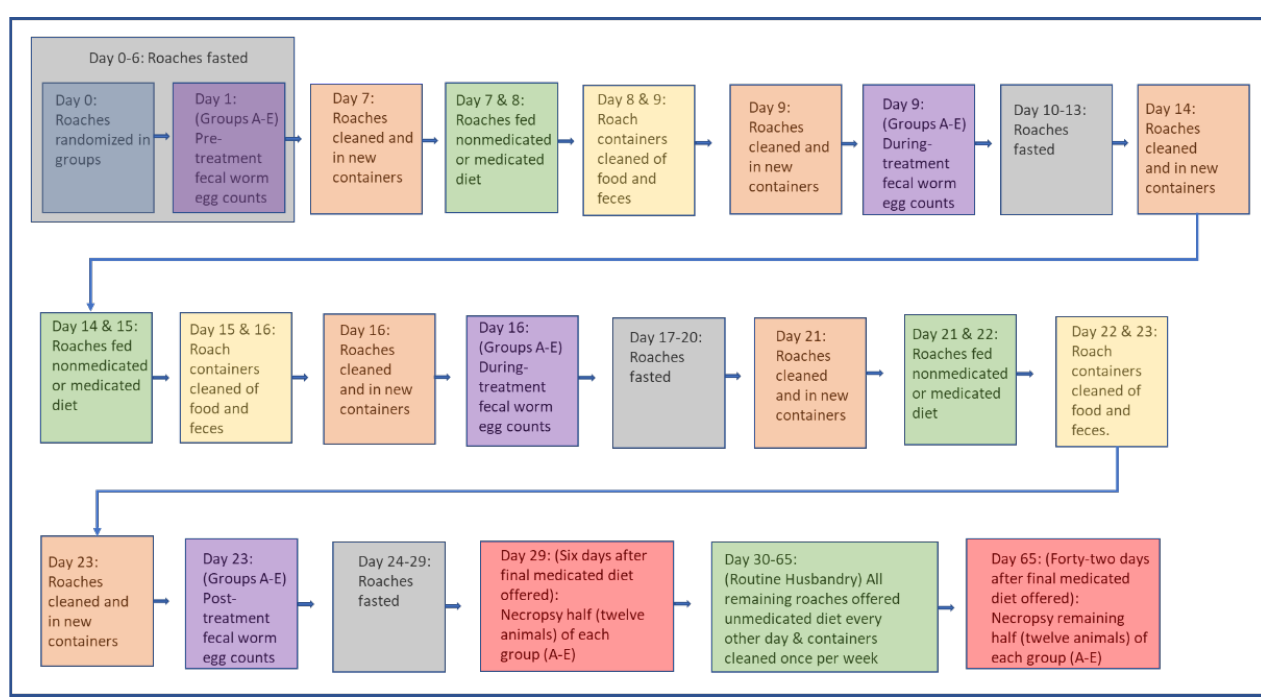
Figure 4. Study design schematic to show workflow from Day 0 to Day 65 of the dubia roach ( Blaptica dubia ) pyrantel pamoate efficiency on passthrough fecal pinworm ( Leidynema appendiculata ) parasites research study.